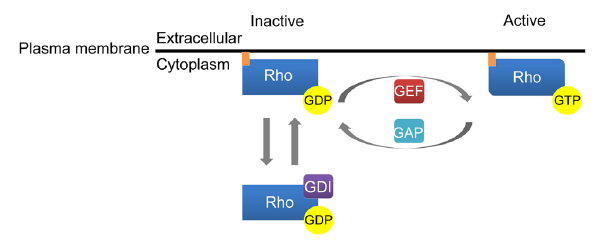
FIGURE 1 |Activation of Rho family GTPases. Guanine nucleotide exchange factors (GEFs) catalyze the conversion of GDP to GTP to enhance Rho GTPase activation. GTPase activating proteins (GAPs) inactivate Rho GTPases by stimulating the ability of Rho GTPases to hydrolyze GTP to GDP. Finally, guanine dissociation inhibitors (GDI) regulate Rho GTPase activation by sequestering Rho GTPases in a GDP-bound state in the